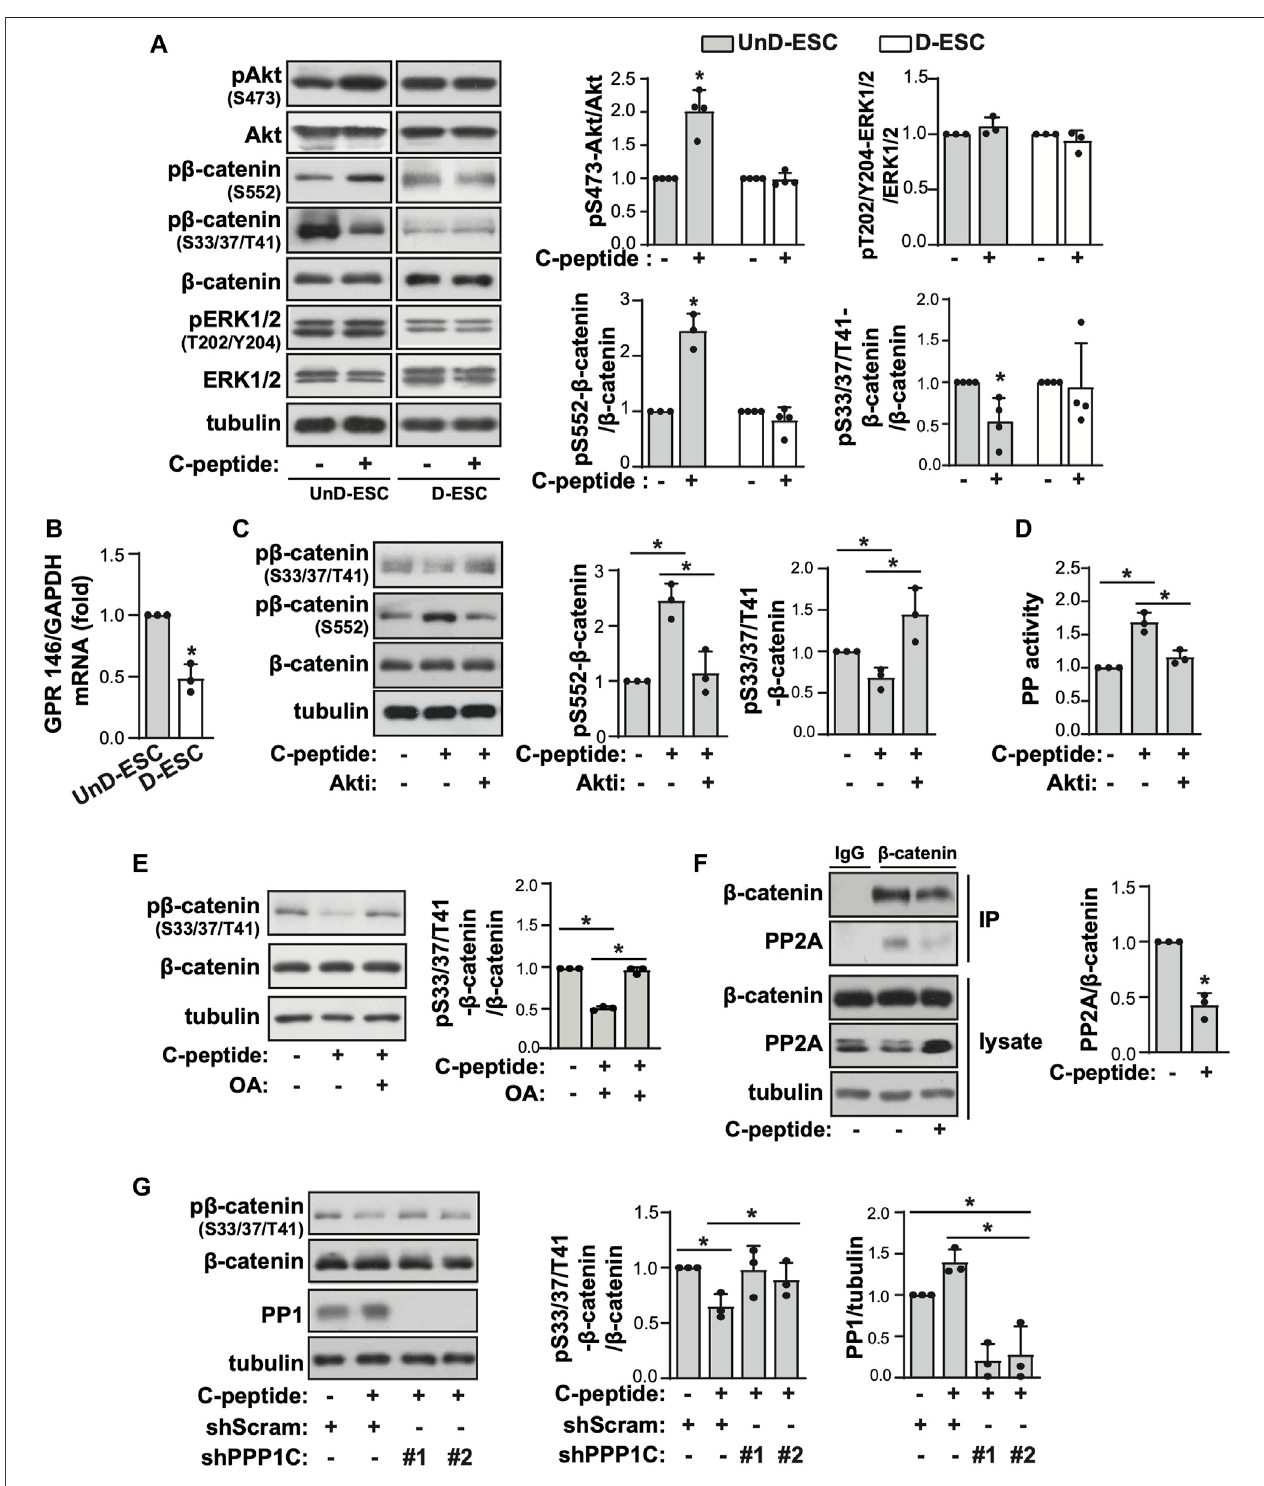
FIGURE 2 | Akt and PP control C-peptide-induced β -catenin phosphorylation. (A) The isolated human endometrial stromal cells (HESCs) were used as the undecidualized HESCs (UnD-ESCs) and decidualized HESCs (D-ESCs) on day 2 after the induction of decidualization in the presence of 8-Br-cAMP. UnD-ESCs and D-ESCs were serum-starved for 48 h and then incubated with 50 nM C-peptide for 10 min. The cells were lysed and subjected to western blot analysis. (B) UnD-ESCs andD-ESCswerelysedandGPR146mRNAlevelwasanalyzedusingqRT-PCR. (C) UnD-ESCswerepretreatedwith1 μ MAktifor1 handtreatedasdescribedin (A) . (D) UnD-ESCsweretreatedasdescribedin (C) andproteinphosphatase(PP)activitywasmeasured. (E) UnD-ESCsweretreatedasdescribedin (A) inpretreatment